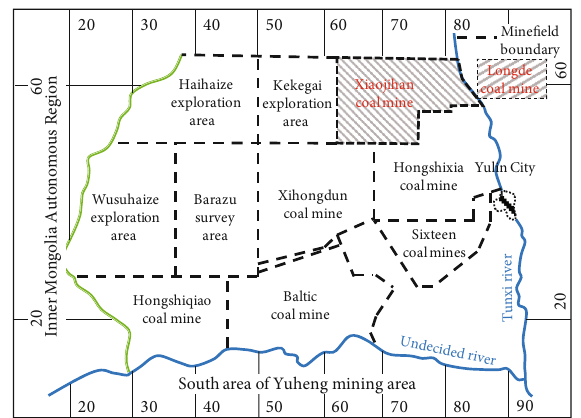
Figure 1: Mine fi eld distribution map of the Yulin mining